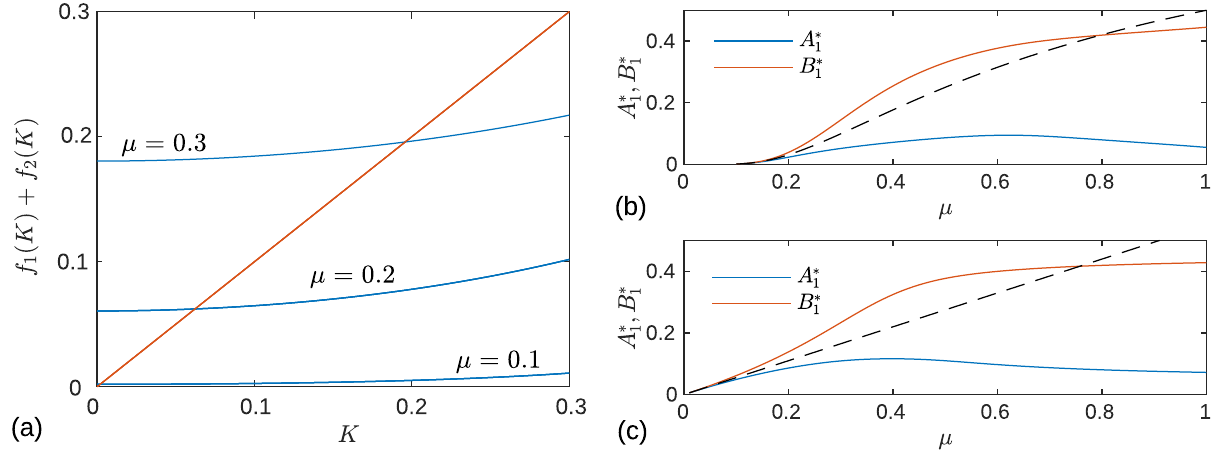
f 2 ( K ) with the identity line. +